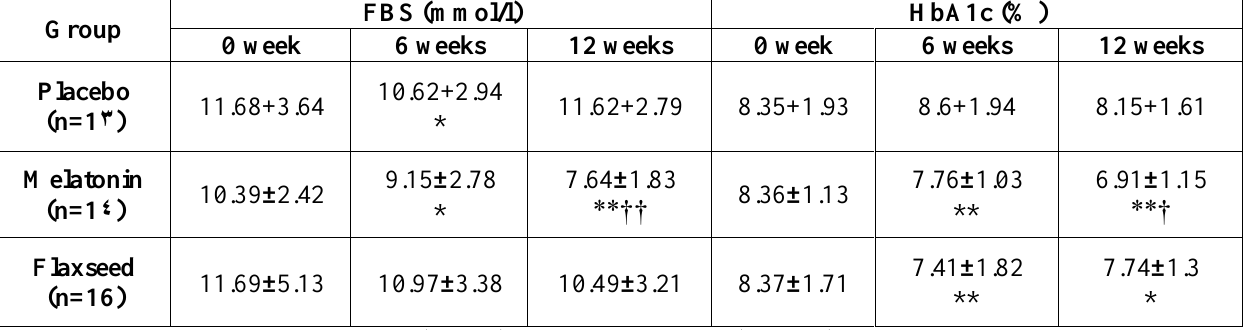
Table 1: FBS and HBA1c levels in each group at varied treatment